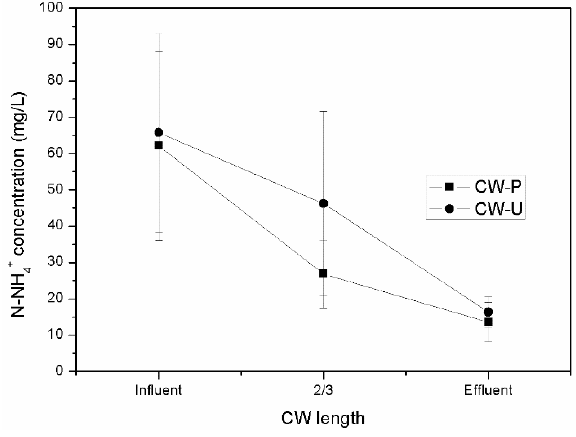
Figure 6. Mean ammonium concentrations along the length of the CW-P and CW-U units.